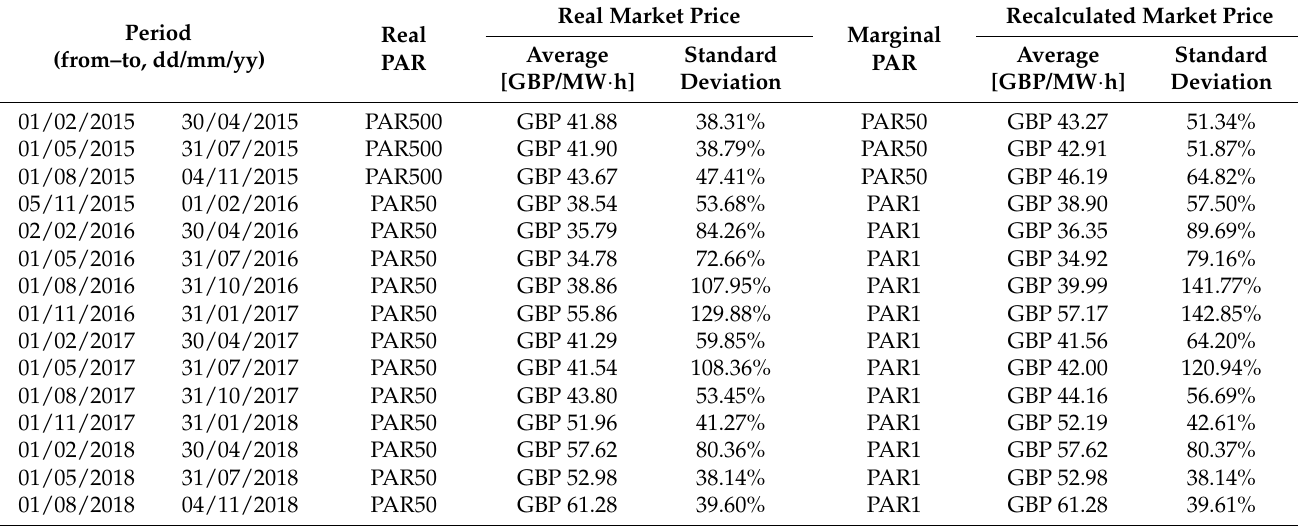
Table 2. Average and standard deviation in different quarters of real market prices and recalculated market prices (i.e., when real market price is calculated with PAR500, the marginal prices is calculated with PAR50, and when the real market price is calculated with PAR50, the marginal price is calculated with PAR1). The standard deviation is assumed as an indicator of volatility. Prices are expressed in constant value terms. Data source: